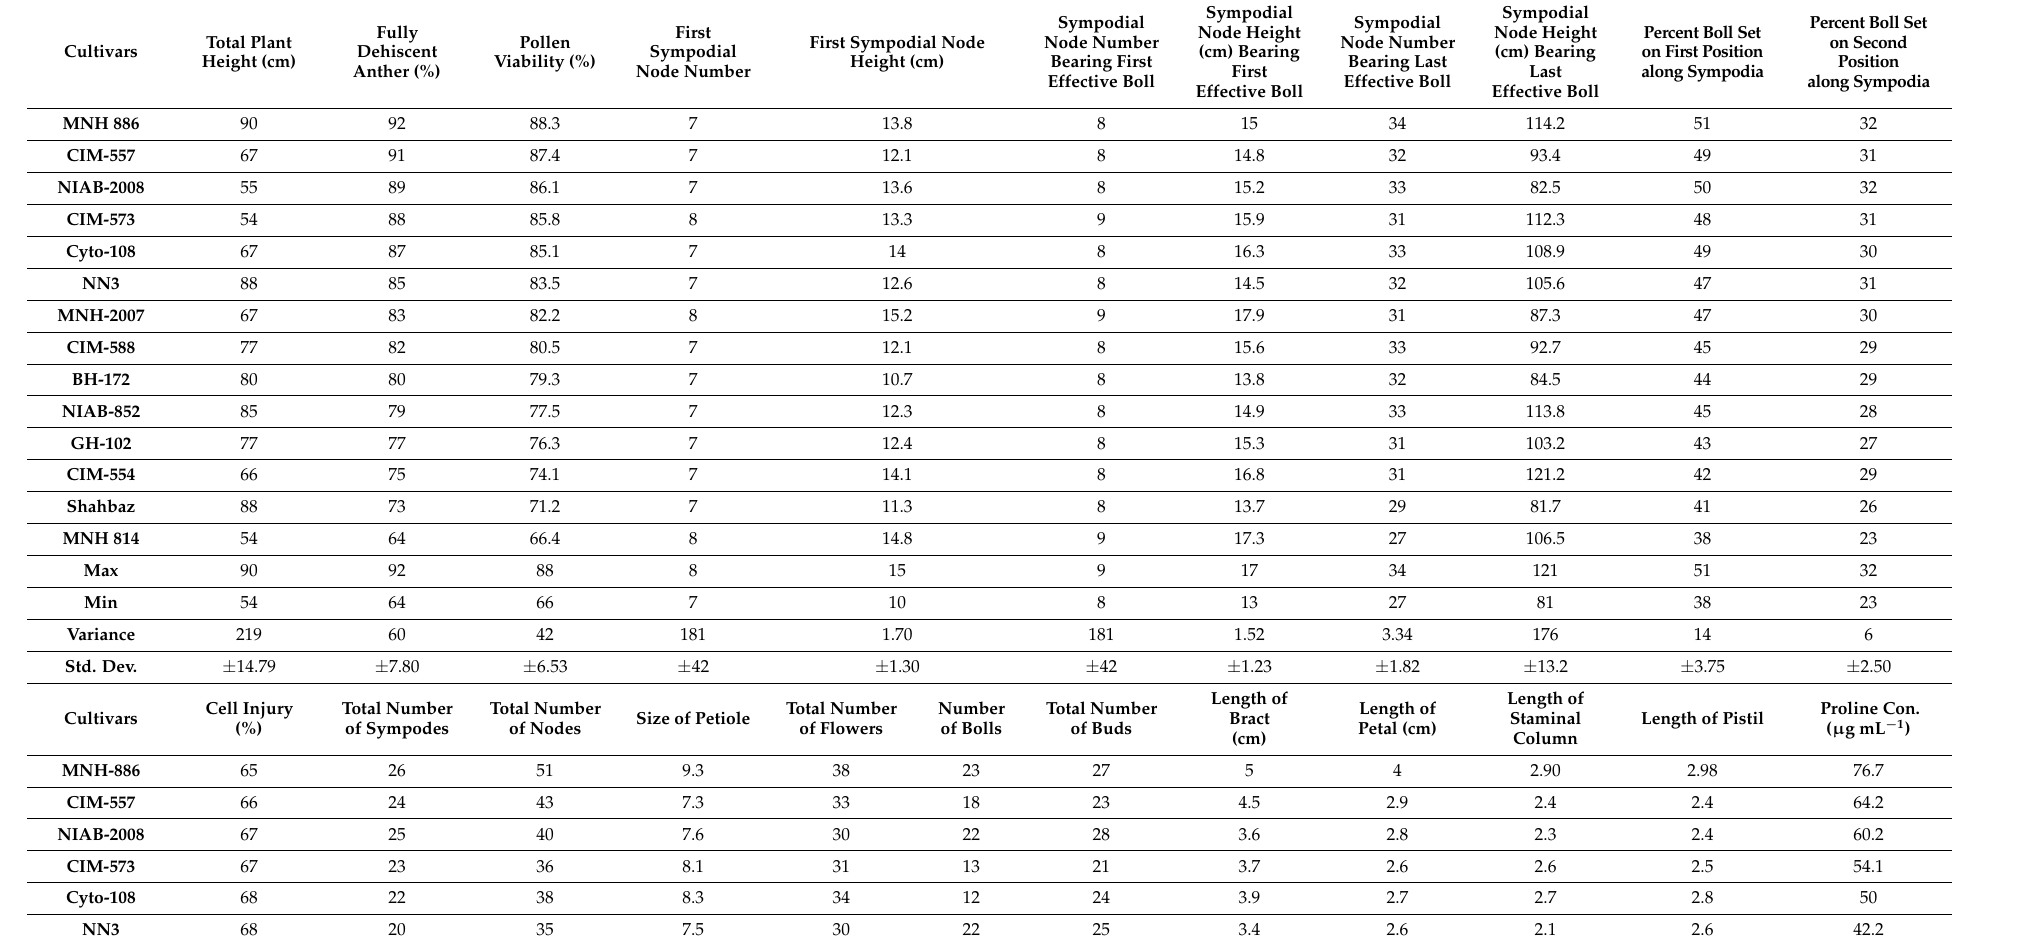
Table 2. Mean values data for 23 morpho-physiological traits of fourteen cotton